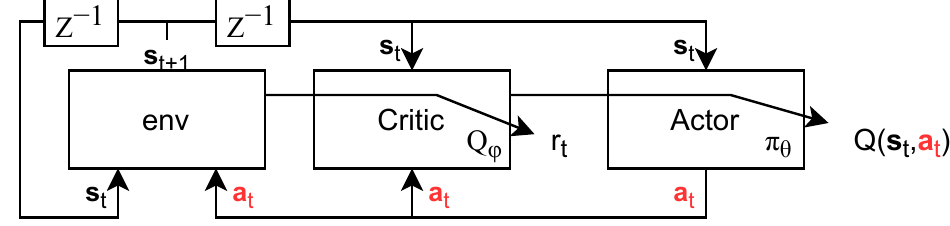
Figure 4. Overview of the actor–critic approach. Curved arrows indicate learning. Time passing with t = t + 1 is displayed Z − 1